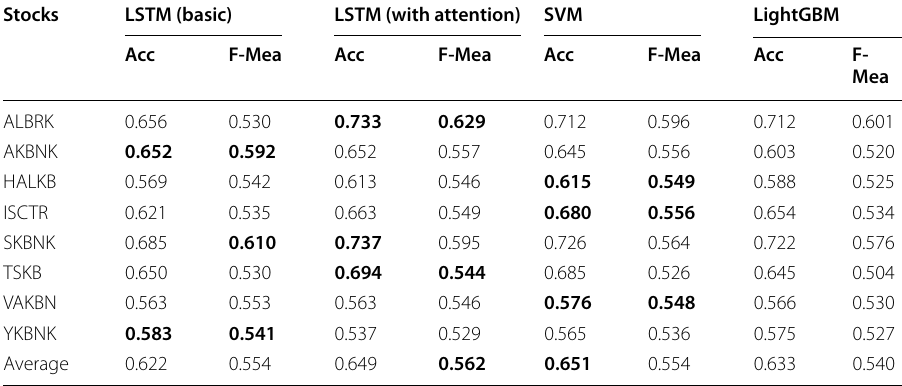
Bold numbers indicate the best performance